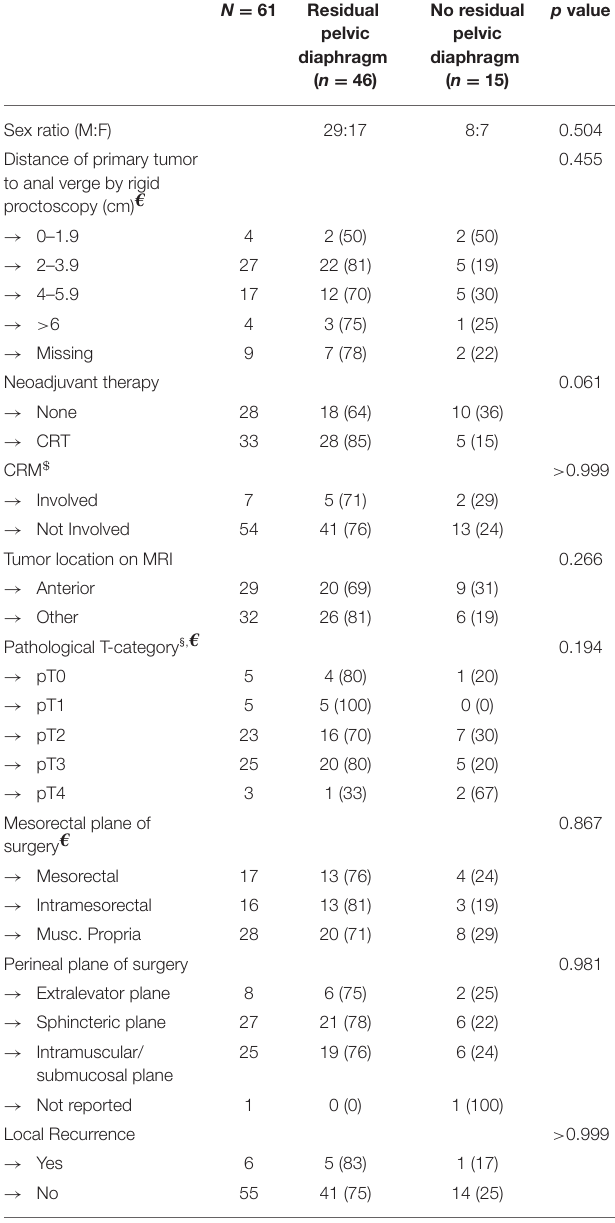
TABLE 2 | RPD on postoperative MRI,